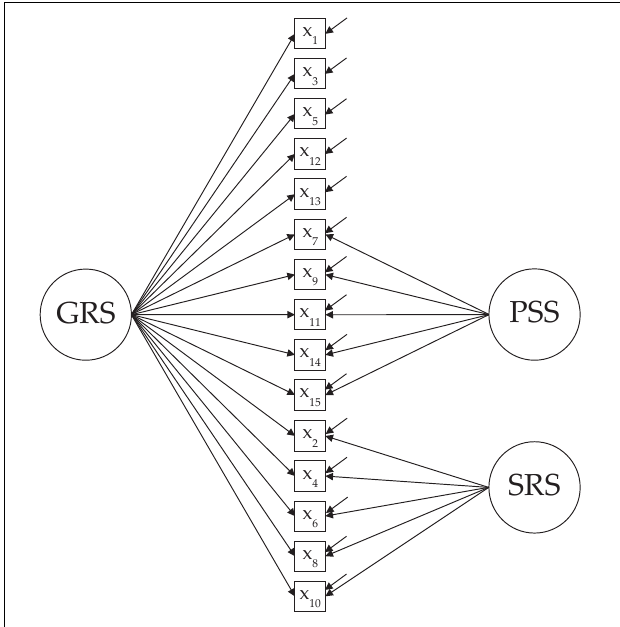
FIGURE 1 | Path-diagram of bifactor S-1 model (global reading strategies as reference general factor). GRS, global reading strategies; PSS, problem solving strategies; SRS, support reading